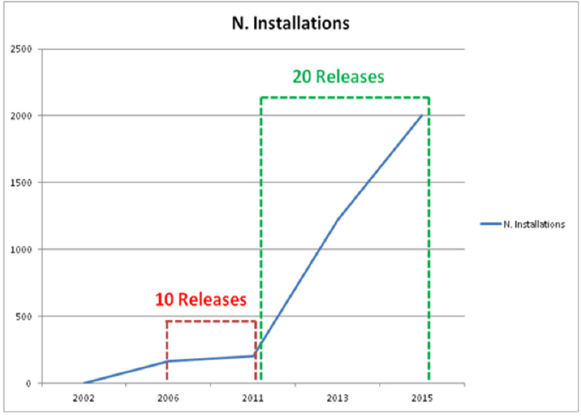
Figure 1. DSpace Releases and Installations.